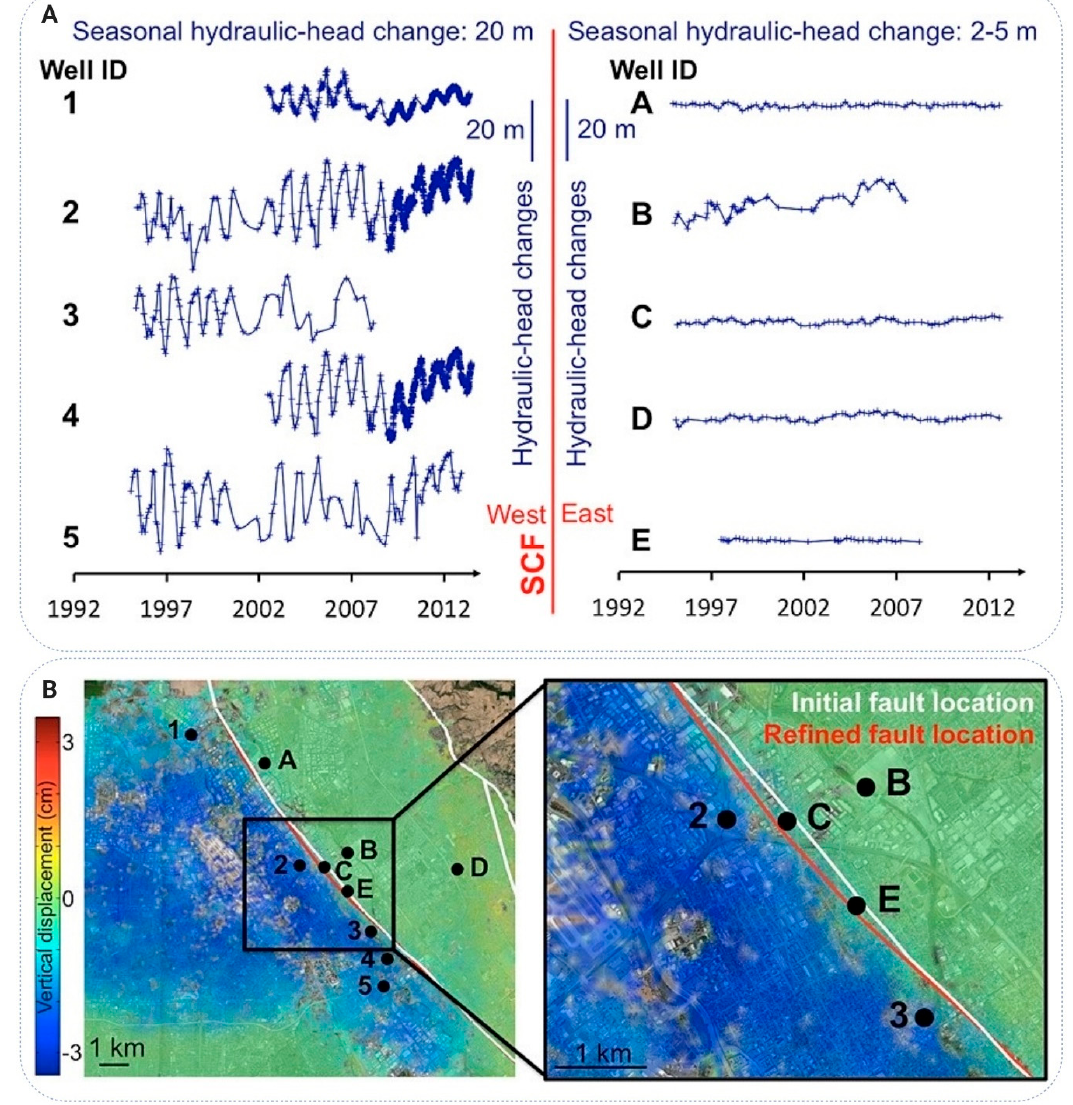
Figure 10. ( A ) Examples of seasonal hydraulic head changes at wells on each side of the Santa Clara Fault (SCF); ( B ) the locations of the well. Wells in the SCV (with seasonal groundwater head changes of approximately 20 m) are labelled with numbers, wells in the Evergreen basin (with seasonal groundwater head changes of approximately 2–5 m) are labelled with letters. ( B ) SCF location based on InSAR deformation only (white line, initial location) and based on InSAR measurements coupled with groundwater head changes (red line, refined location). The right inset shows two wells, C and E, originally located west of the SCF (white line), which show only 2 m of seasonal hydraulic head changes. Accordingly, the SCF trace was relocated westward (red line); modified after [95].